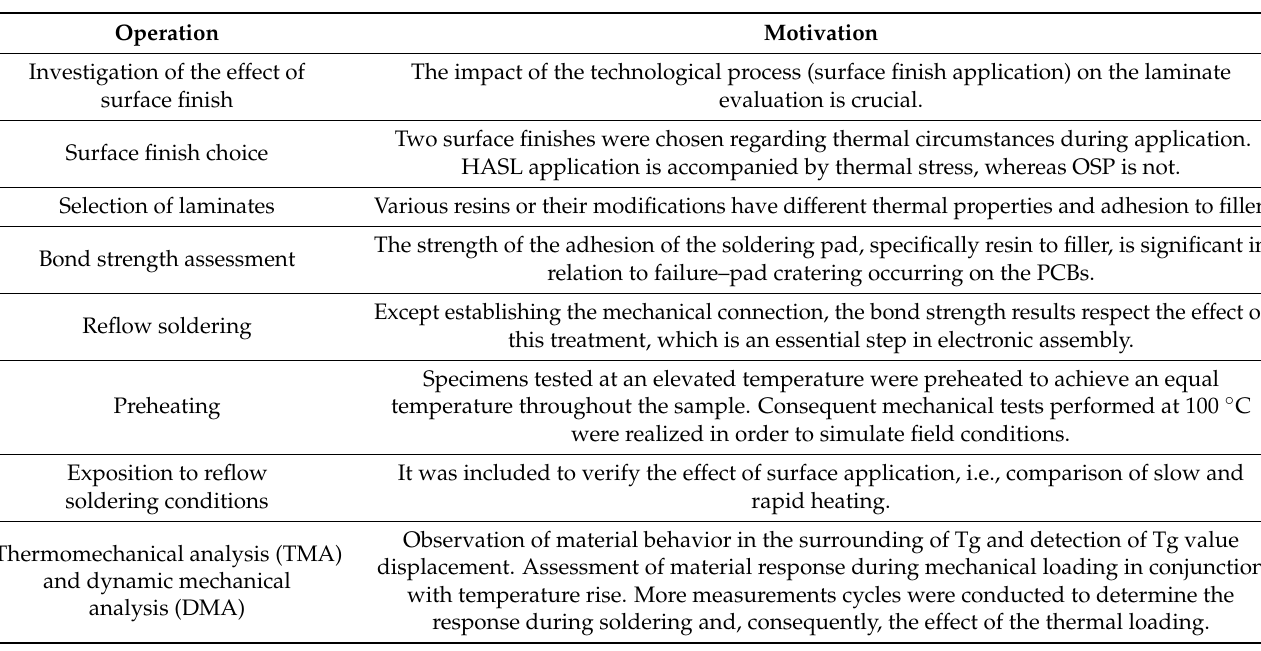
Figure 6. Research methodology. Table 2. Explanation of the main motivations.